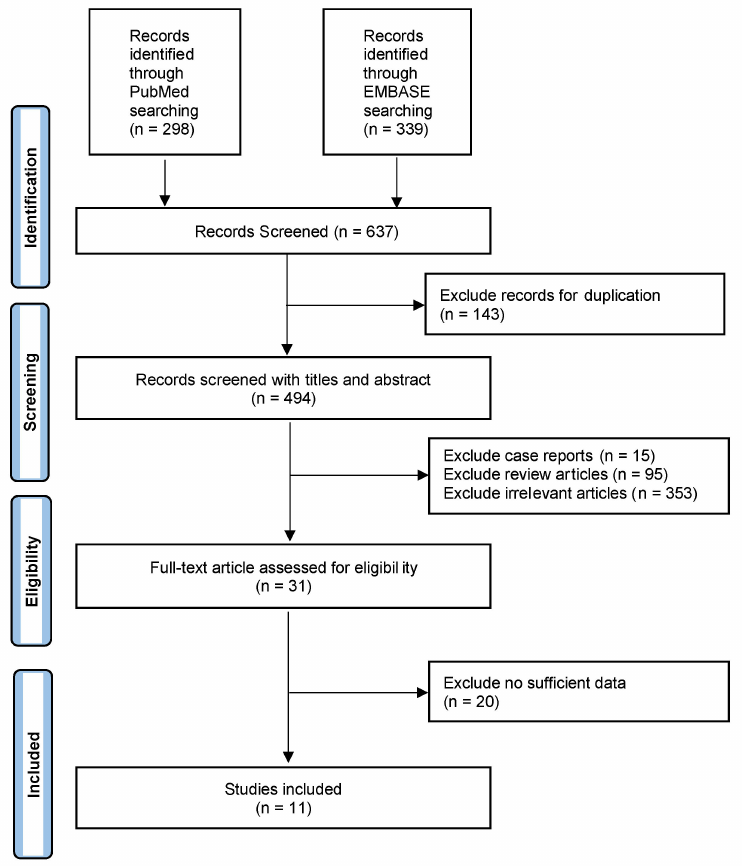
Figure 1. Workflow of the literature search for the diagnostic performance of ultrasound in detecting extrathyroidal